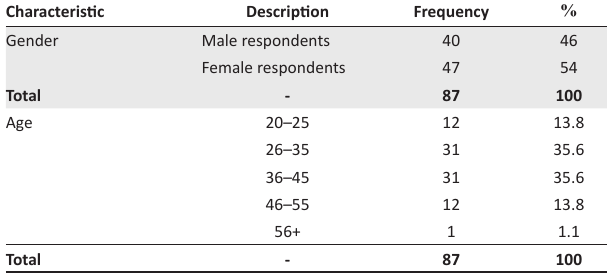
TABLE 2: Sample profile characteristics.